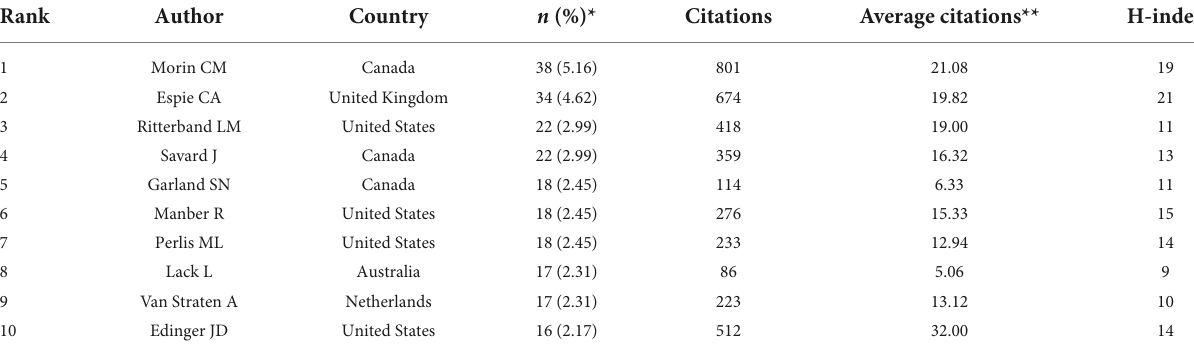
TABLE 2 Top 10 authors in terms of publications on CBTI.